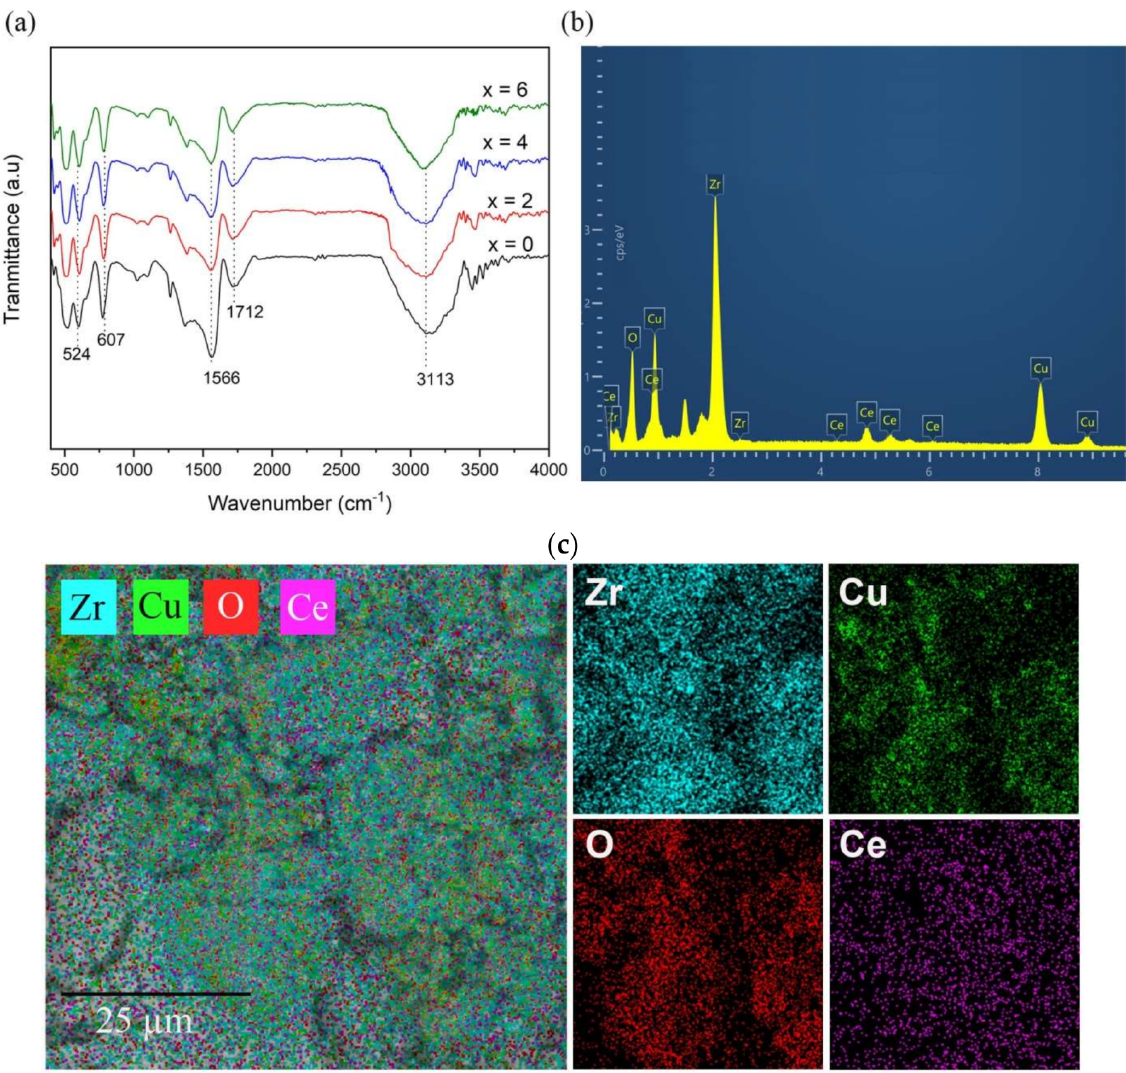
Figure 4. ( a ) FT-IR of x mol% Ce 3+ /Ce 4+ -doped ZrO 2 /CuO (x = 0; 2; 4; 6), ( b ) EDS, ( c ) mapping imaging of 8 mol% Ce 3+ /Ce 4+ -doped ZrO 2